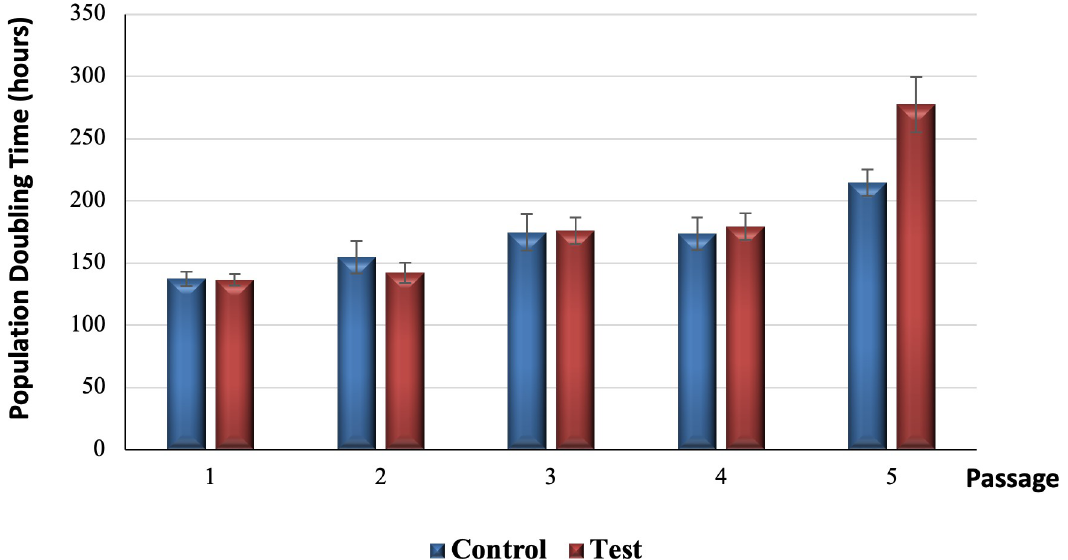
Fig 5. Population doubling time of control and test groups from passage 1 to passage 5.